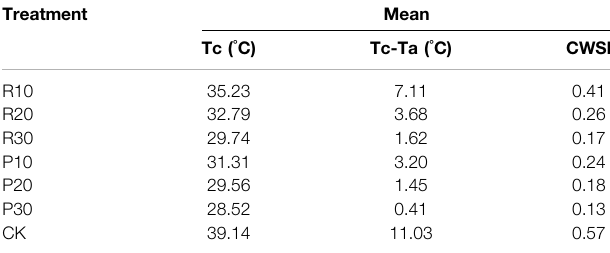
TABLE 2 | Analysis of the mean of the canopy temperature, the difference between canopy temperature and air temperature, and the crop water stress index of alfalfa under different irrigation methods in the study